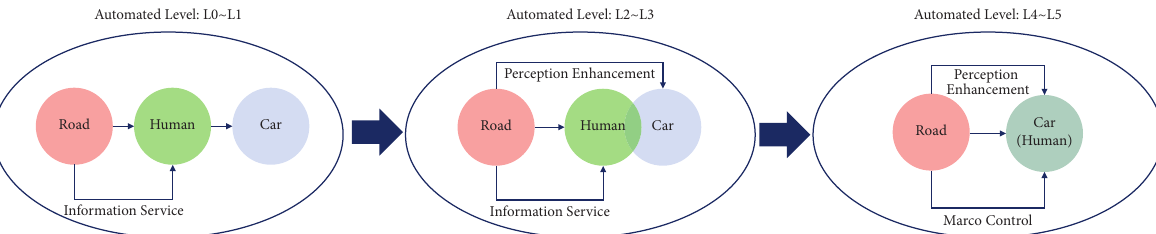
Figure 3: Functions of NGSH for different level of